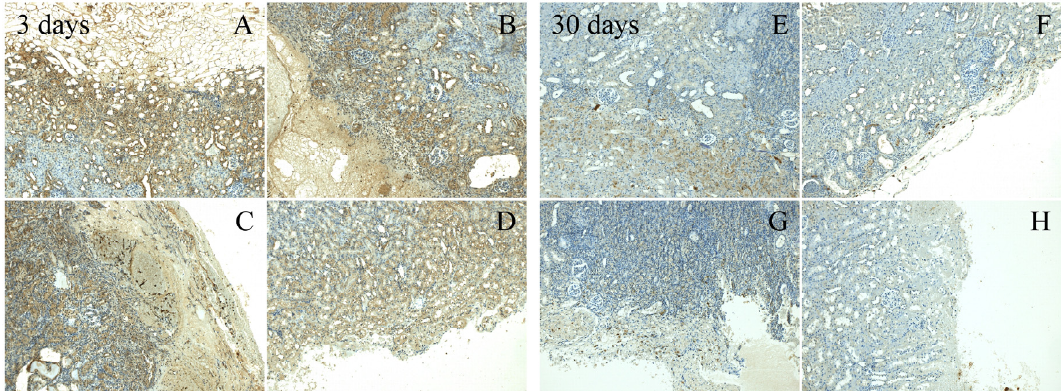
Figure 5. Immunohistochemical staining of TNf- α at 100× magnification. After 3 days (left section); ( A ) ORC, ( B ) HA/OX, ( C ) HA/CMC, ( D ) HA/CMC/ET: all new textiles B–D with light expression (+), reference textile A, medium expression (++). After 30 days (right section); ( E ) ORC, ( F ) HA/OX, ( G ) HA/CMC, ( H ) HA/CMC/ET: no expression (-) at E–G, light expression (+) at H.